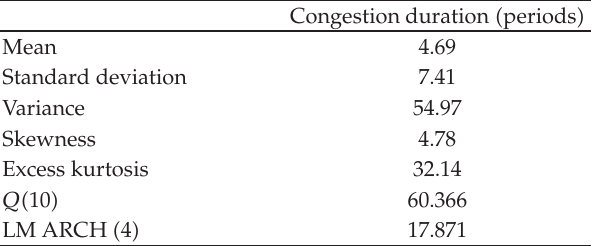
Table 2: Statistical specifications of (cid:3) a (cid:4) congestion duration data and (cid:3) b (cid:4) the duration of related uncongested tra ffi c